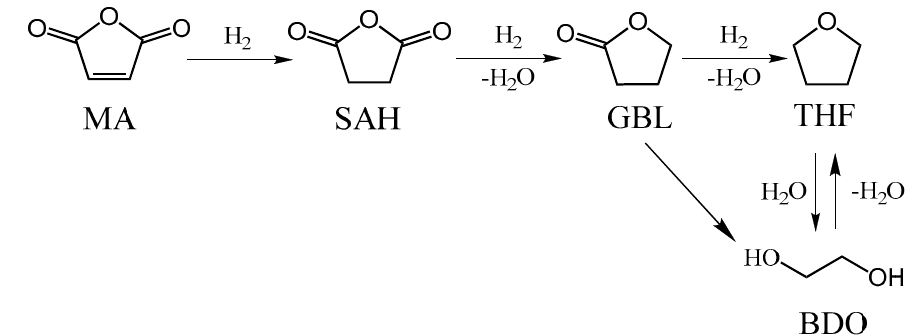
Figure 1. Reaction scheme of hydrogenation of maleic anhydride (MA).